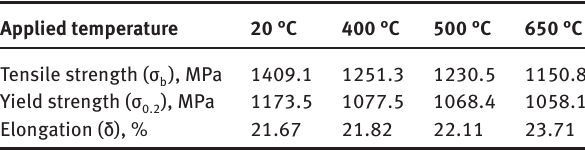
Table 2: Mechanical properties of GH4169 alloy at different temperatures